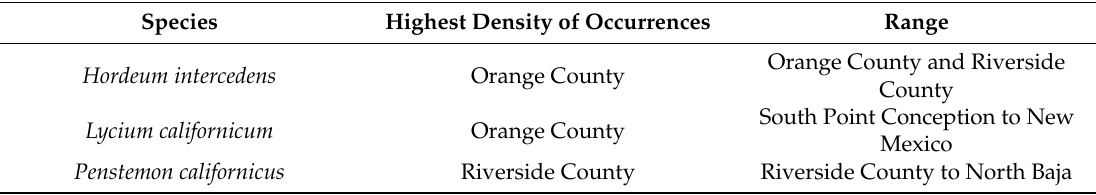
Table A4. Rare species located in the NCC Reserve that are more longitudinally distributed having a limited North to South range.